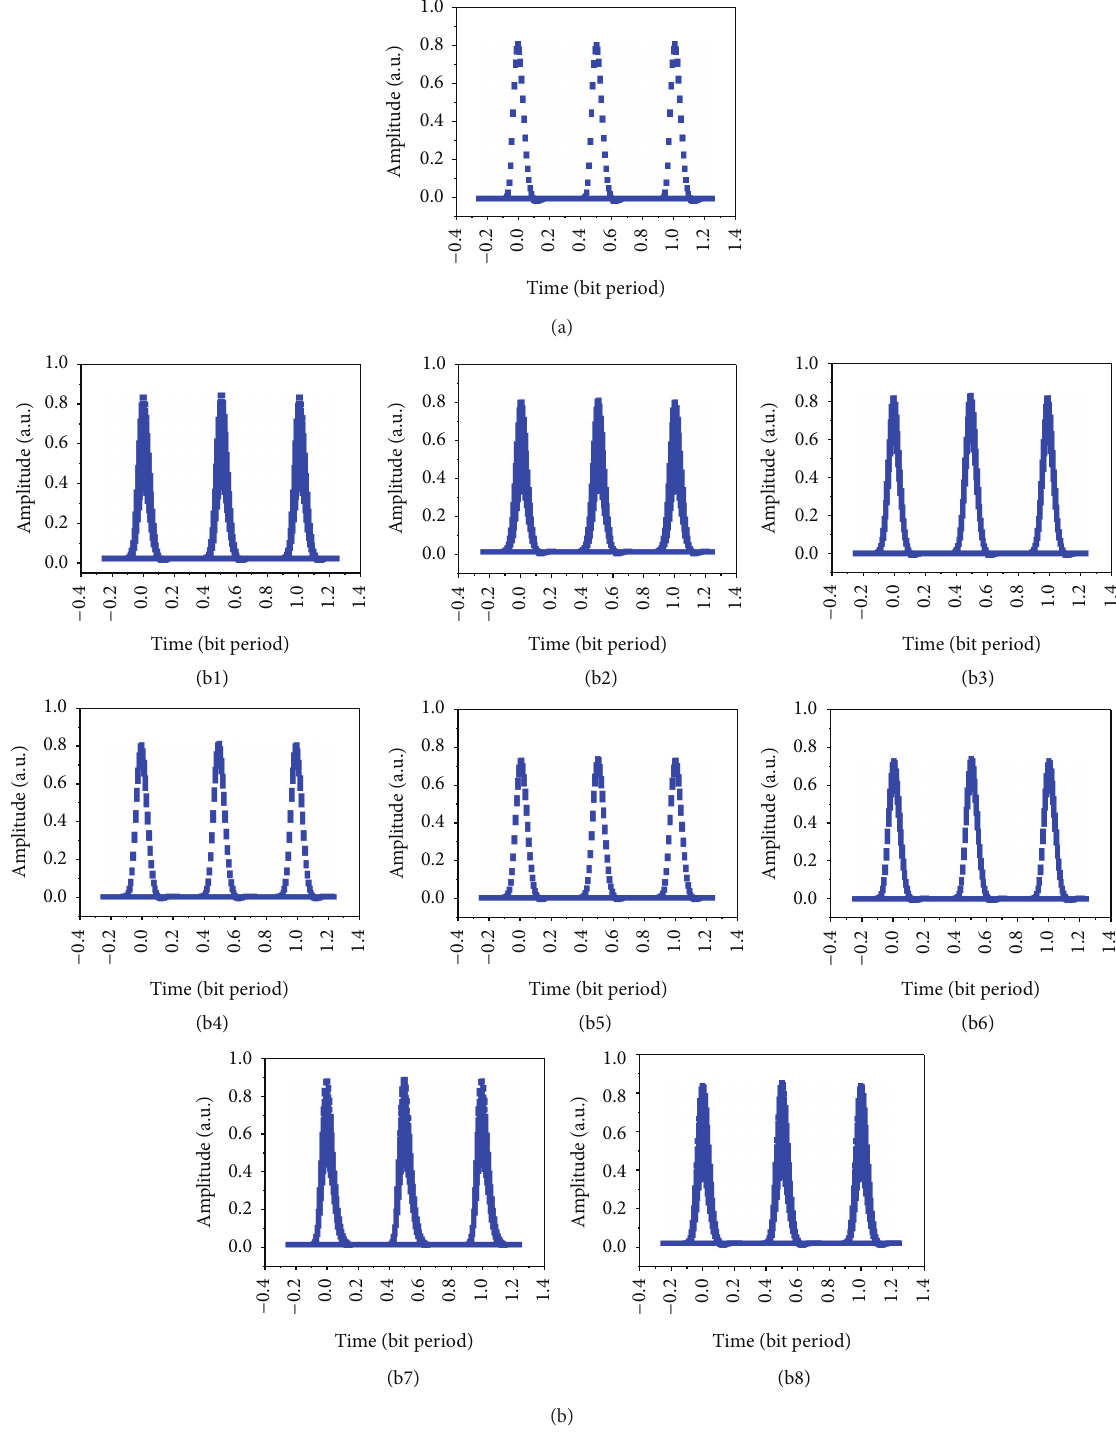
Figure 2: Eye diagrams of the simulation for (a) original RZ signal and (b1)–(b8) eight filtered multicasting channels.